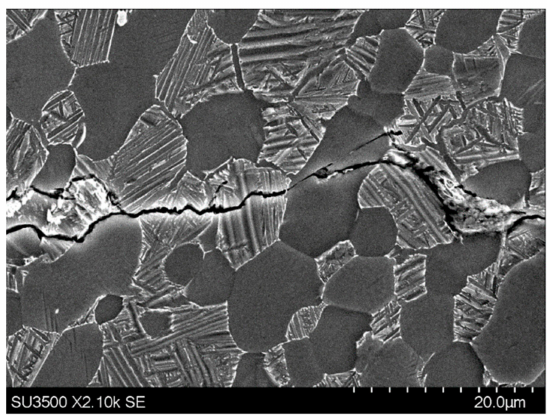
Figure 11. Local crack / microstructure interactions in Ti-407 (crack growth from left to